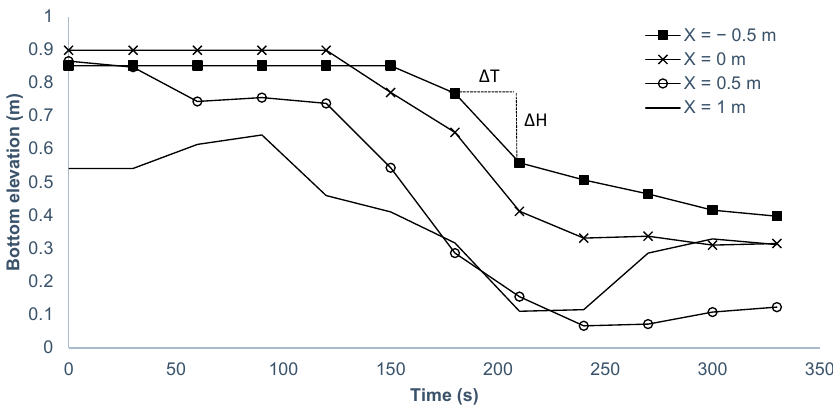
Figure 10. Vertical breach development model U4 (central core). The bottom elevation on the vertical axis is the Z coordinate from the DEM.